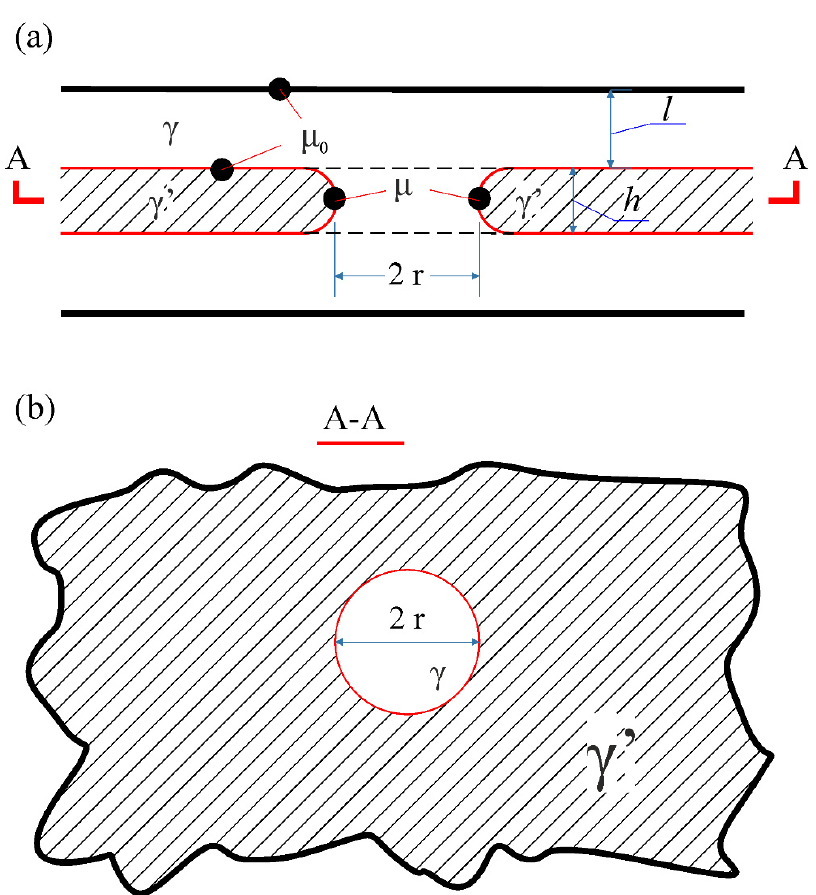
Figure 7 . Schematic representation of a hole-like defect in the plate of the γ ’—phase; ( a , b )—the sections perpendicular ( a ) and parallel ( b ) to the layers, accordingly [39,40]. Copyright 1994 Elsevier.